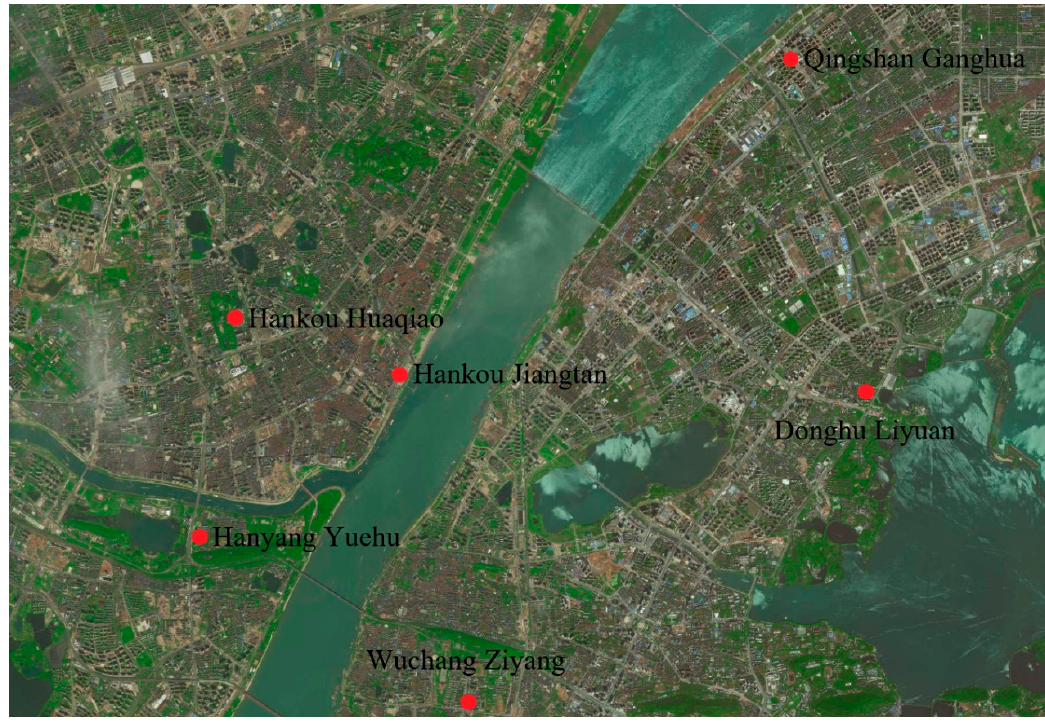
Figure 1. Distribution of monitoring sites. Table 1. Relevant information of monitoring devices used.